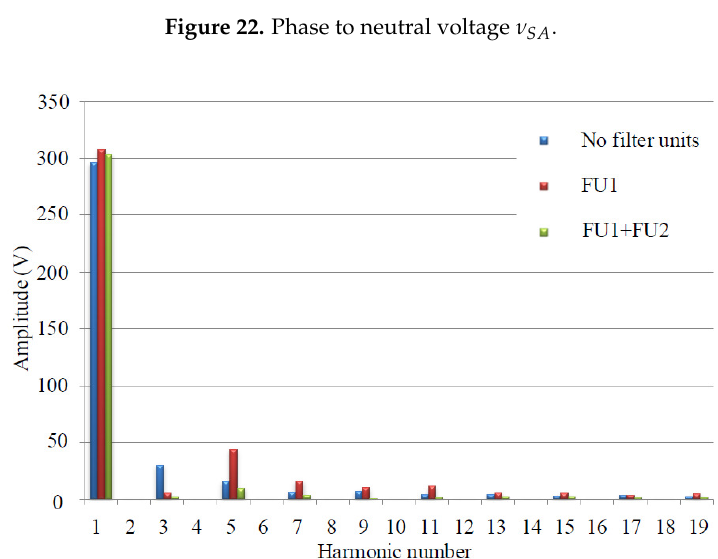
Figure 23. The voltage ν SA